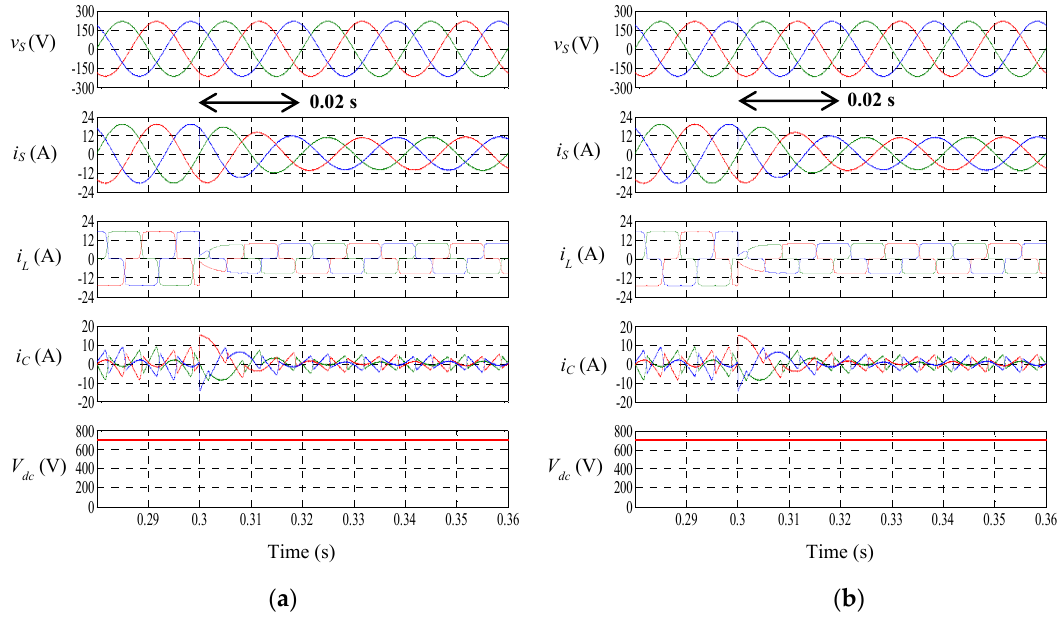
Figure 13. Simulation result of SAPF under transient-state condition of high to low current which includes the three-phase source voltage v S , source current i S , compensation current i C , and DC bus voltage V dc , obtained from SAPF ( a ) with FLC and ( b ) without FLC.